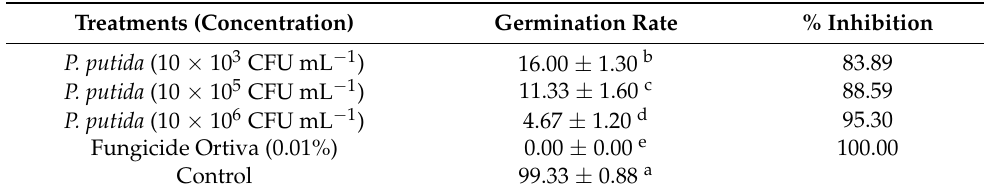
Table 2. Inhibitory impact of Pseudomonas putida strain ASU15 on germination rate of uredospores of Uromyces appendiculatus.